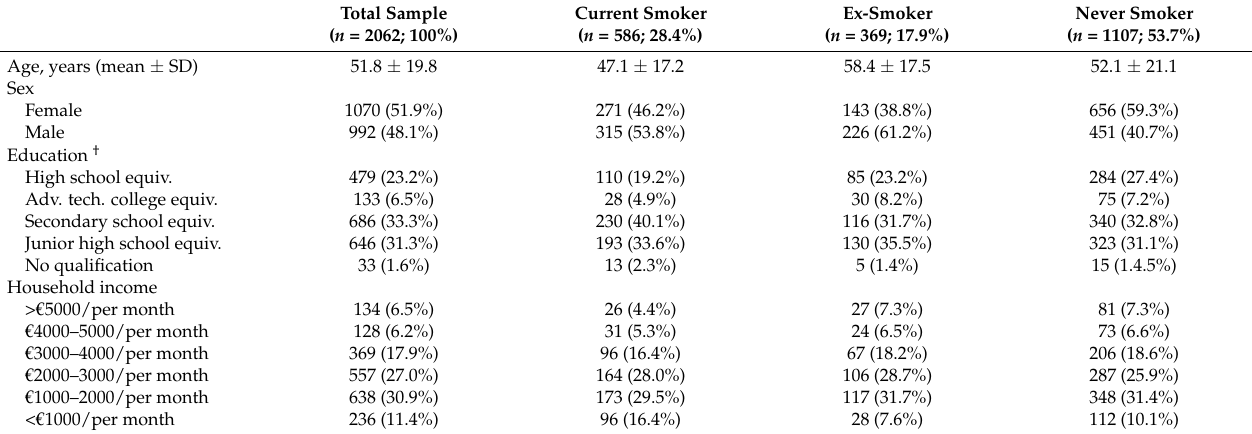
Table 1. Unweighted baseline characteristics of the total sample, and by smoking